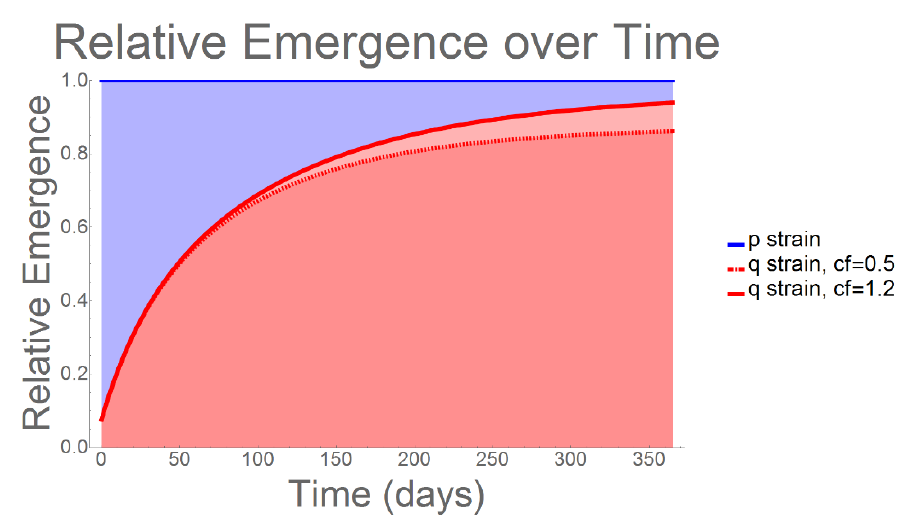
Figure 1. Relative Emergence: Using the extremal comparators of resistant strain comparative fitness (cf) = 0.5 and 1.2, we analyzed the resulting changes to relative emergence. Even when its evolutionary fitness is low (0.5), q-strain dominance occurs immediately and rapidly; among all infections, 80–95% can be expected to be antibiotic-resistant, irrespective of percent prophylaxis treatment among HIV/AIDS patients.